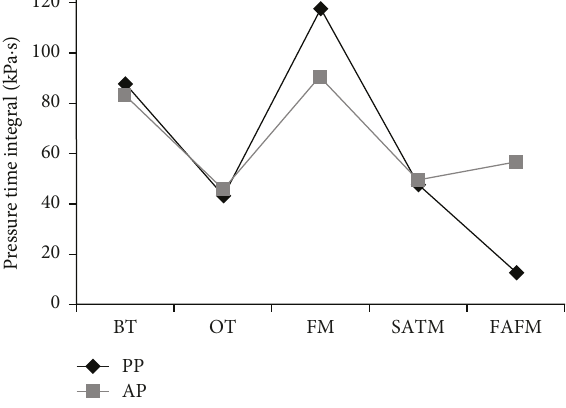
Figure 3: The pressure-time integrals of the AP and